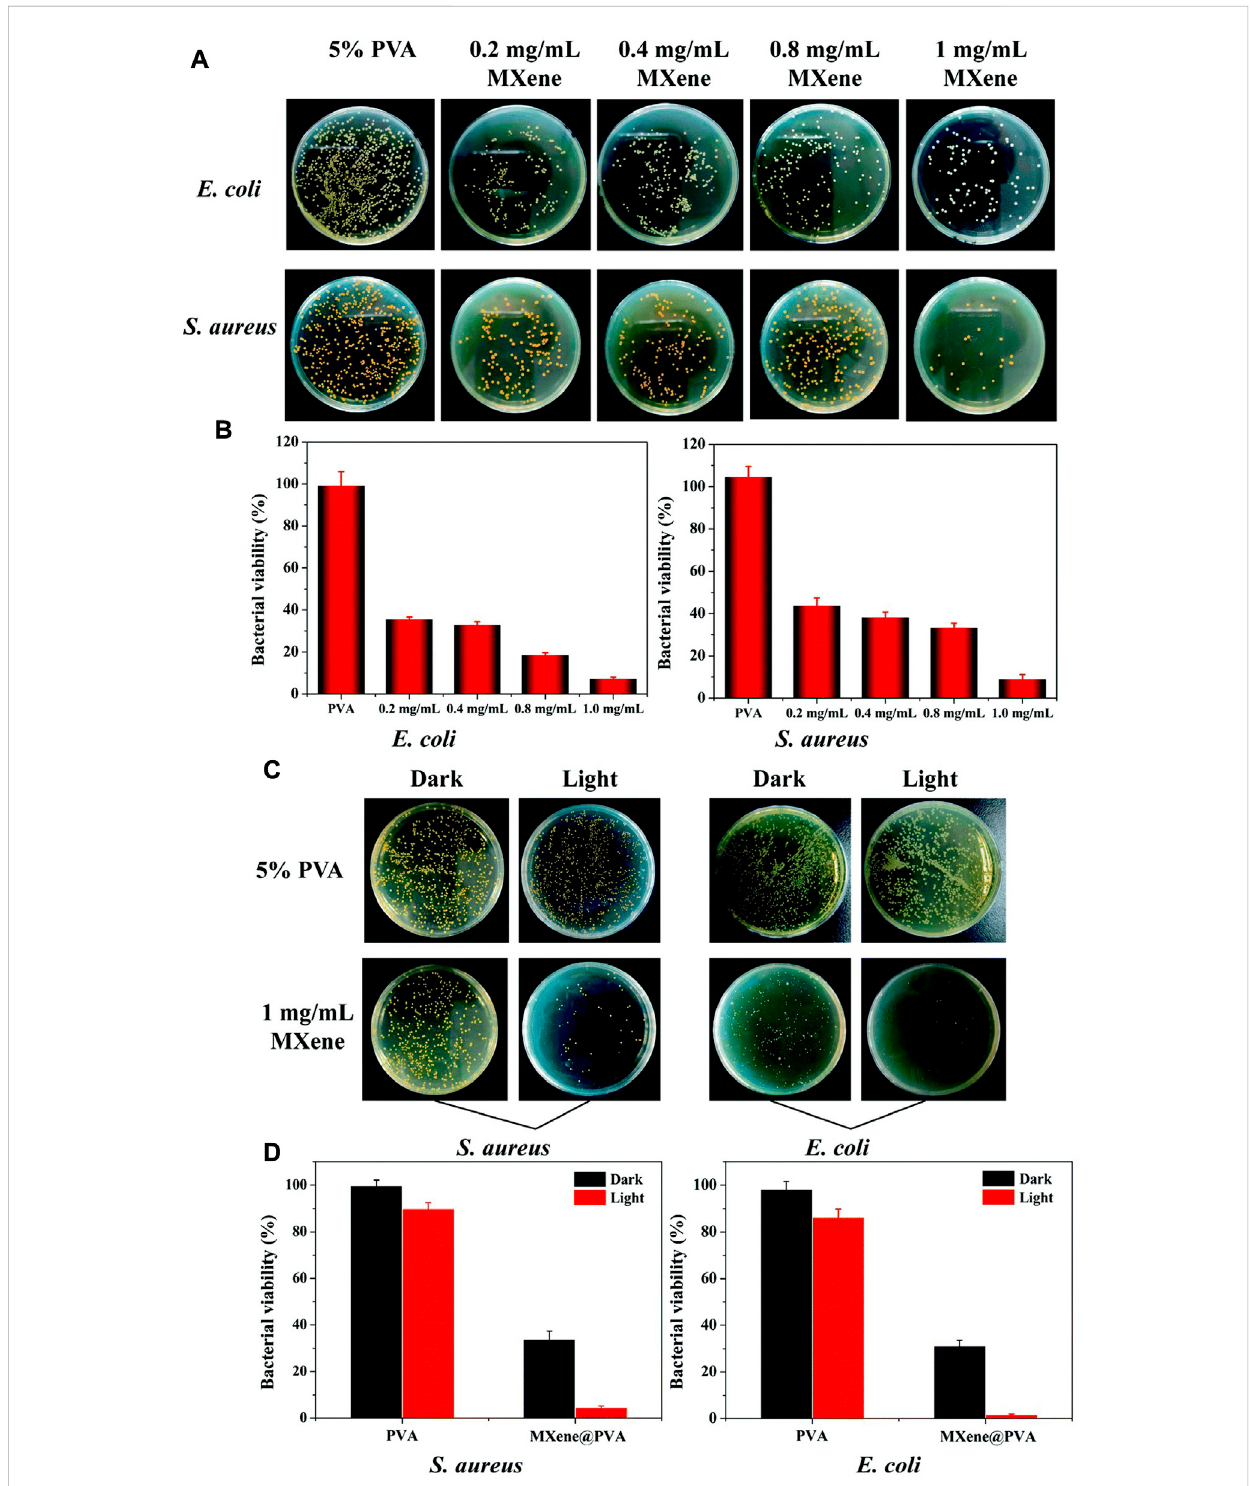
Antibacterial ability of MXene-modi fi ed MXene@PVA hydrogel (A) Photograph of bacterial colonies of Escherichia coli and Staphylococcus aureus treated with differentconcentrations of MXene. (C) Photograph ofbacterial colonies formedby Escherichia coli and Staphylococcus aureus treated with the PVA hydrogel, the PVA hydrogel + NIR, MXene@PVA hydrogel (1 mg/ml MXene) and the MXene@PVA hydrogel (1 mg/ml MXene) + NIR. The power density was 1.5 W/cm 2 , and the operation time was 10 min (B) ; (D) corresponding survival rates for Escherichia coli and Staphylococcus aureus (Li et al.,